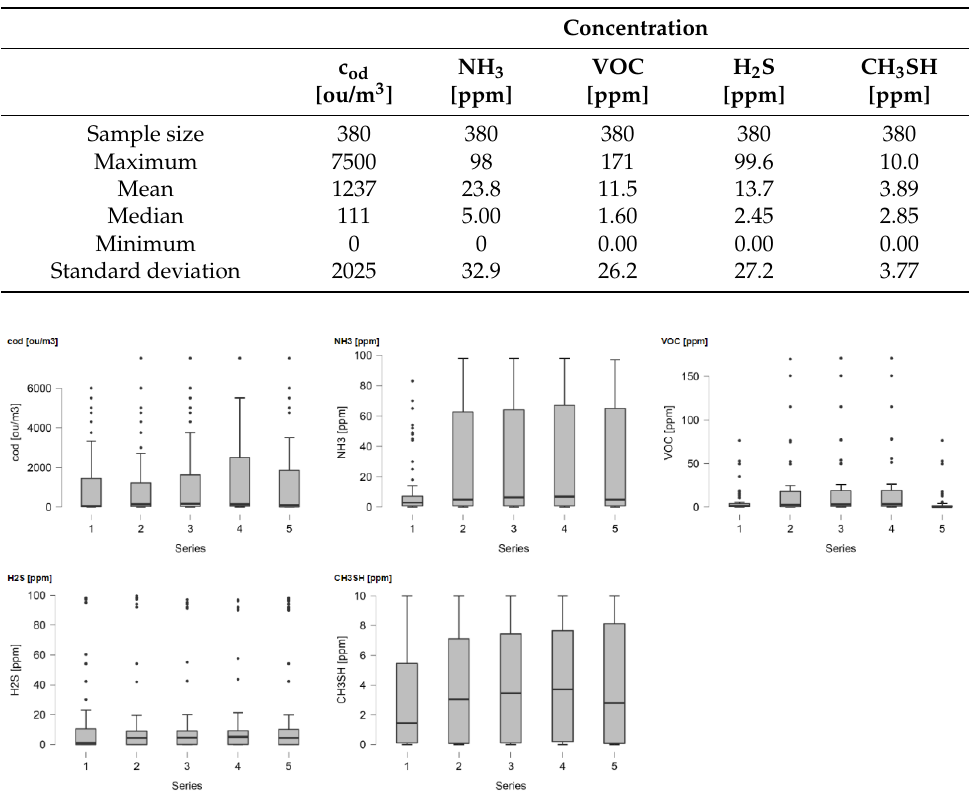
Figure 2. Spatial distribution of hydrogen sulphide concentration in series 2. Table 3. Descriptive statistics of the results achieved in all measurement series.